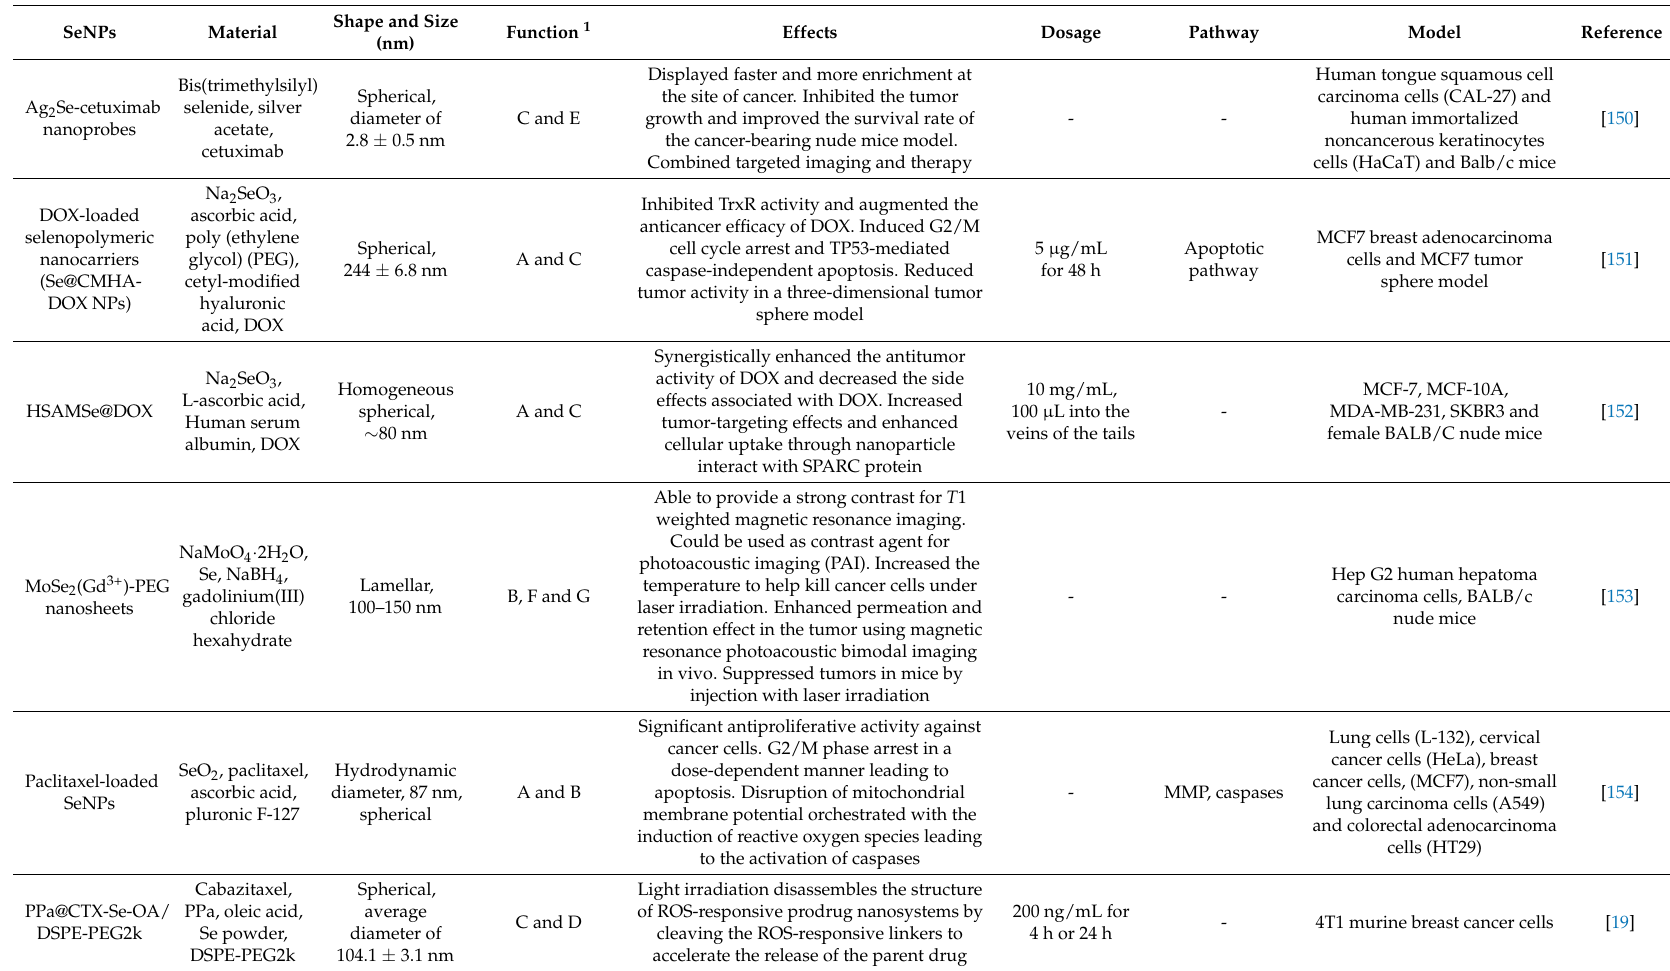
Table 4. Summary of recent work on multi-functional SeNPs with potential in cancer-related